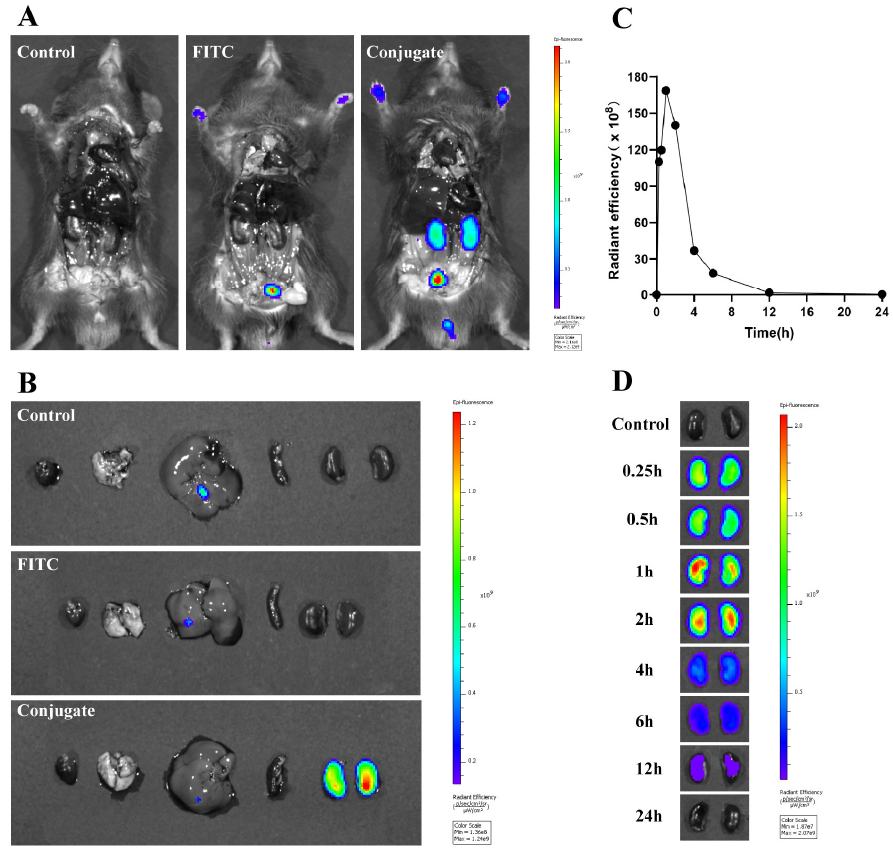
Figure 9. Biodistribution of FITC-labeled MPS–LZM in vivo. ( A ) Representative whole body distribution of FITC-labeled MPS–LZM or equivalent free FITC 1 h after tail vein injection; ( B ) Excised main organs 1 h after tail vein injection were collected and photographed; ( C ) Quantitative analysis of fluorescent signal of excised kidneys at di ff erent time intervals; ( D ) Excised kidneys at di ff erent time intervals after injection were compared and photographed.